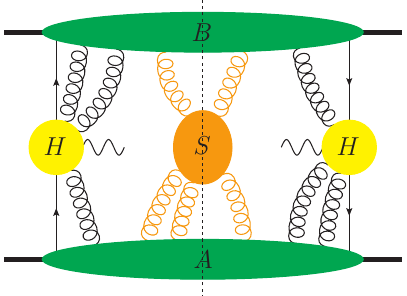
Figure 3: The partitioning of the leading DY graphs in the TMD case into various subgraphs (represented by ‘blobs’) that are each characterised by a particular momentum scaling. The right- and left-moving collinear subgraphs are denoted by A and B respectively, the soft (plus Glauber) subgraph by S , and the hard subgraphs by H